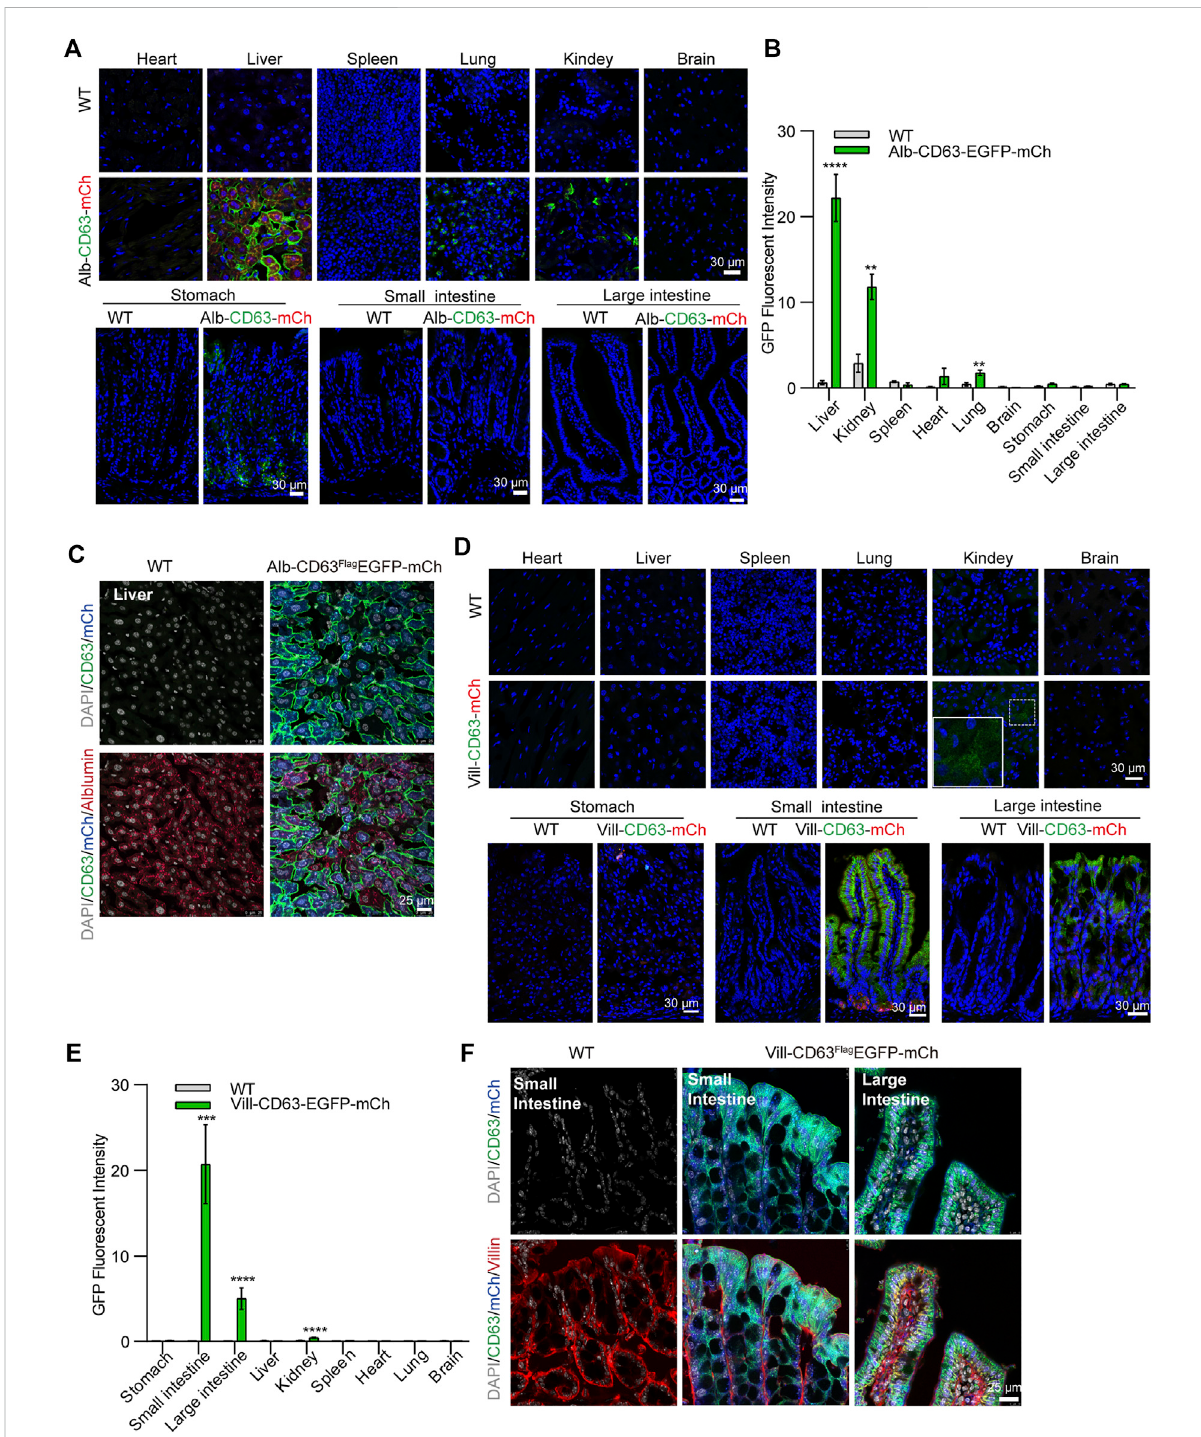
FIGURE 2 Confocal microscopic image analysis of tissue speci fi c CD63FlagEGFP-mCherry mouse (A) Merged Confocal microscopy image of Alb- CD63 Flag EGFP-mCherry mouse tissues.Blue,Nucleus; Green,GFP; Red, mCherry (Scale bar, 30 um). (B) Statistical analysis of GFP fl uorescent intensity of each tissue of Alb-CD63 Flag EGFP-mCherry mouse. (3 mice/group, three to four discontinuous slices for each tissue) (C) Immunostained cell type of liver (albumin) colocalization with EGFP and mCherry fl uorescent in the liver of Alb-CD63 Flag EGFP-mCherry mouse. Grey, Nucleus; Green, GFP; Blue, mCherry;Red,Albumin(Scalebar,25um). (D) MergedConfocalmicroscopyimageofVillin-CD63 Flag EGFP-mCherrymousetissues.Blue,Nucleus;Green, GFP;Red,mCherry(Scalebar,30um) (E) StatisticalanalysisofGFP fl uorescenceintensityofeachtissueofVillin-CD63 Flag EGFP-mCherrymouse.(3mice/ group,threetofourdiscontinuousslicesforeachtissue) (F) Immunostainedcelltypeofintestine(villin)colocalizationwithEGFPandmCherry fl uorescent in the intestine of Villin-CD63 Flag EGFP-mCherry mouse. Grey, Nucleus; Green, GFP; Blue, mCherry; Red, Albumin (Scale bar, 25